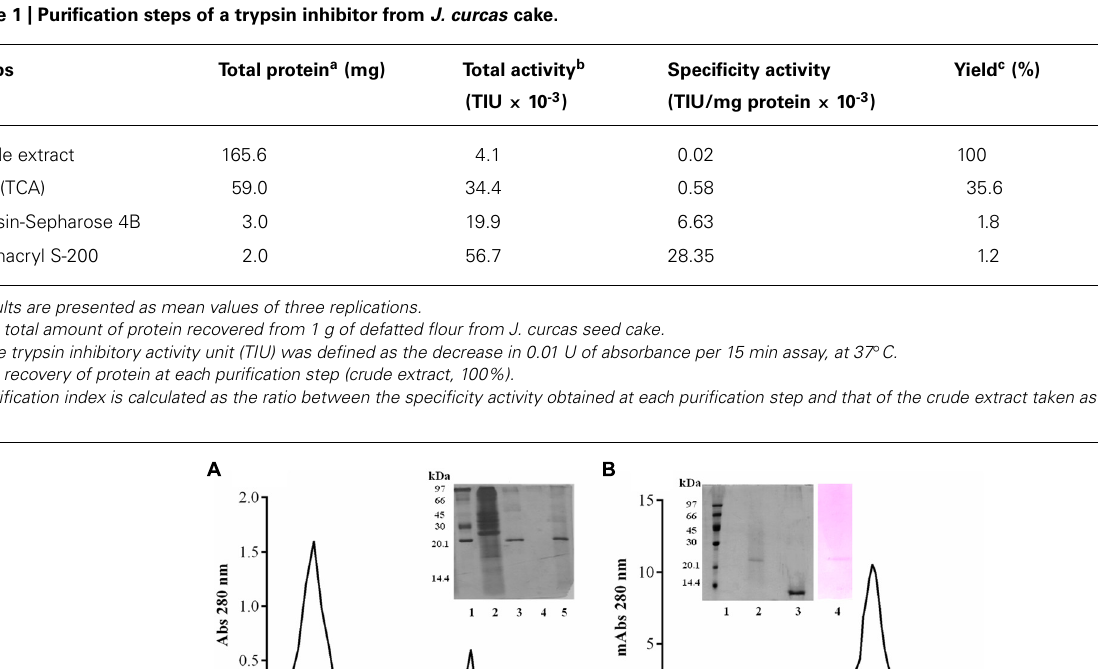
after chromatography onTrypsin-Sepharose 4B column. Inset: SDS-PAGE: (1) molar mass markers; (2 and 3) JcTI-I (5 μ g) in the absence and presence